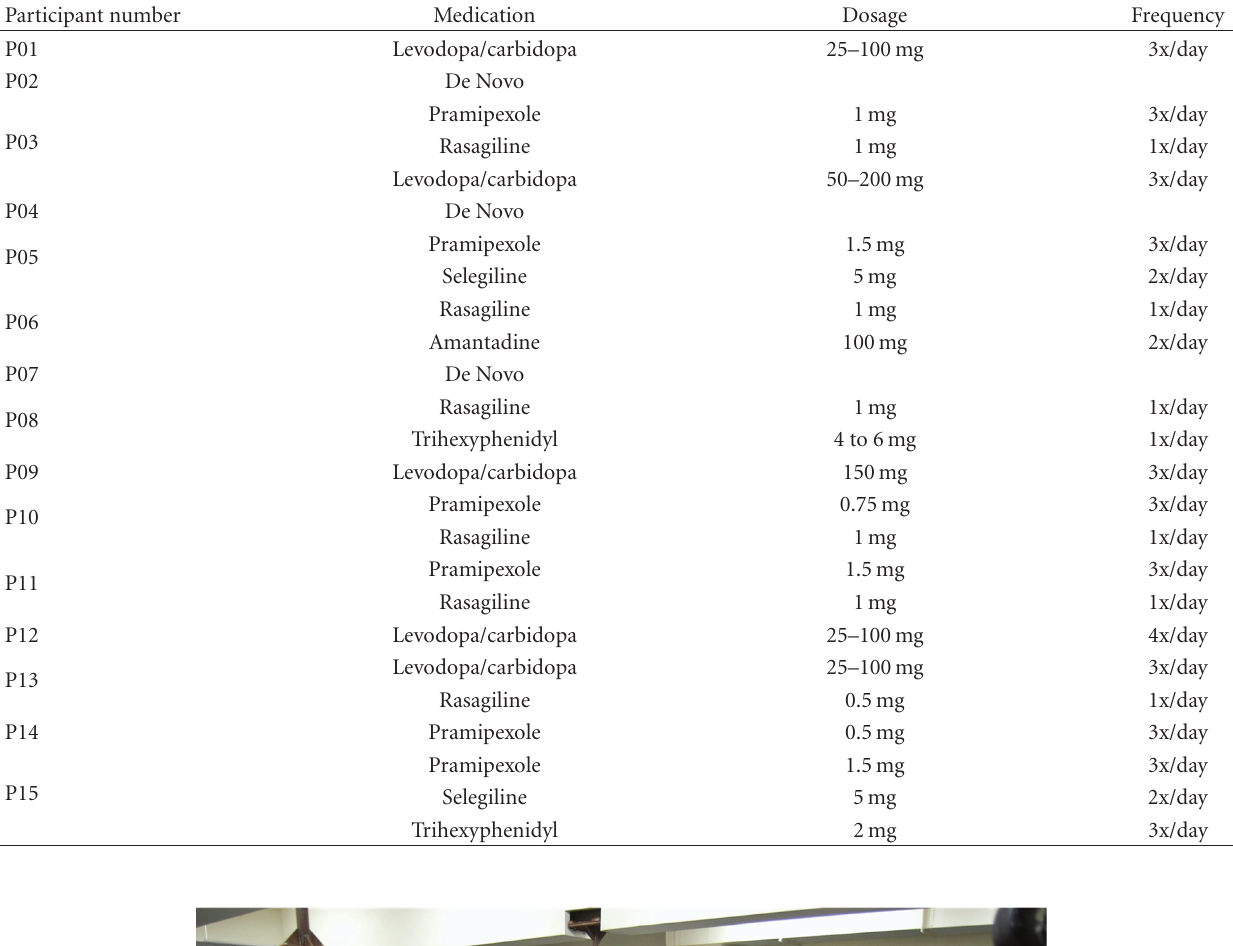
Table 2: Dosage of Parkinson’s medications.